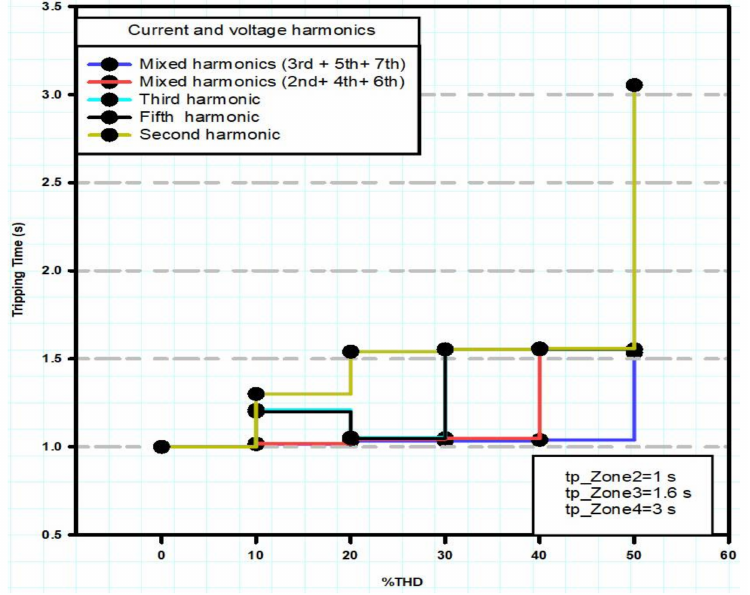
Figure 13. Distance relay: tripping time (seconds) vs. %THD